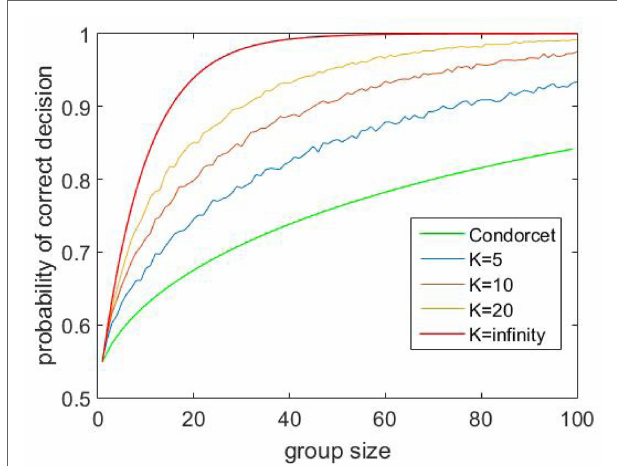
FIGURE 2 | Using irrelevant alternatives to improve group performance- a simulation study. Group performance curves (calculated from a computer simulation) as a function of the number of total alternatives K using our new voting procedure. The percentage of experts in the crowd is fixed at 10% for this plot. The different colors of curves illustrate how varying the group size N influences group performance for a fixed K . The green curve gives a comparison with Condorcet theorem (which is technically equivalent to the case N = 2). See Appendix A3 for proof of why performance always exceeds the Condorcet